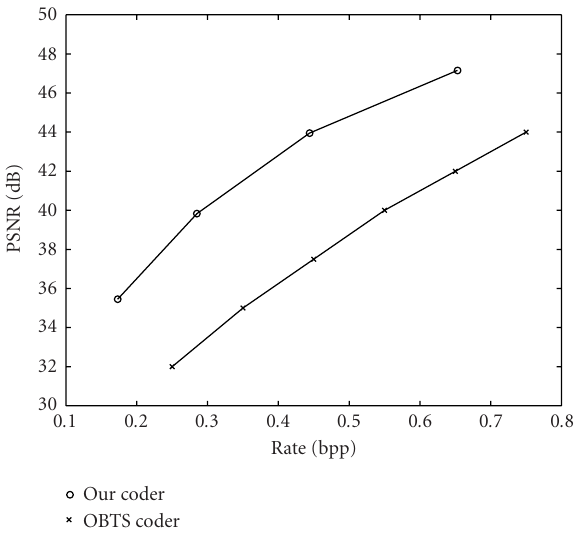
Figure 4: Rate-distortion performance comparison for cmpnd2 be- tween our two-class coder and DjVu